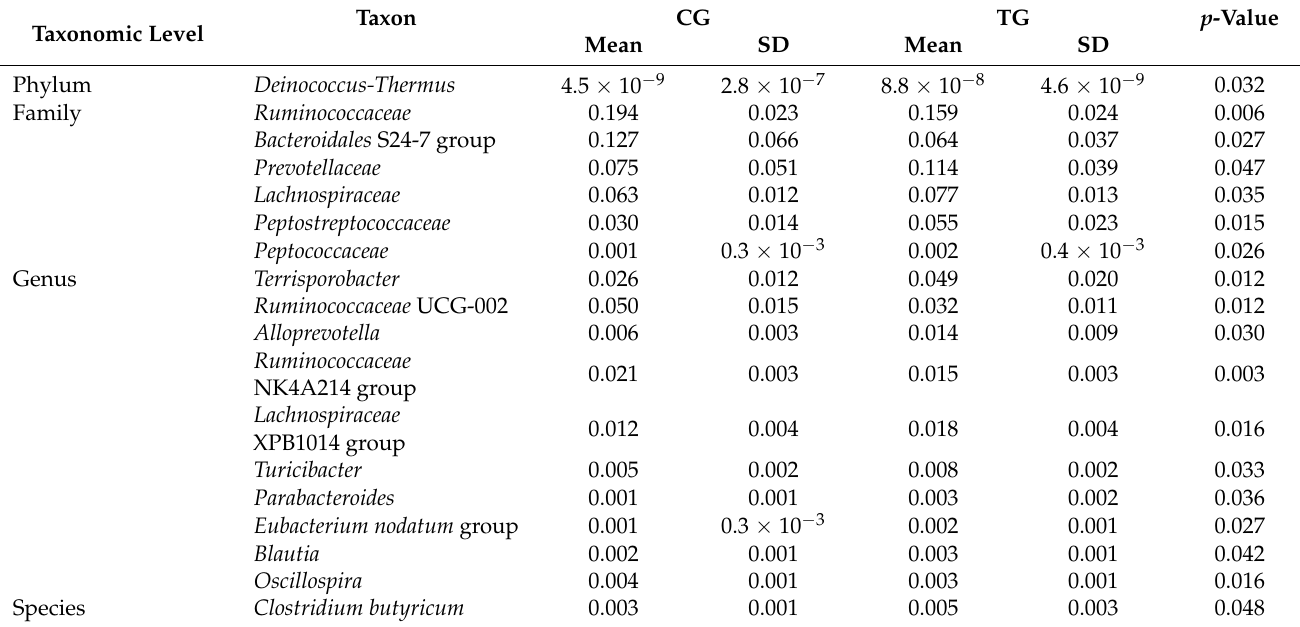
Table 2. t -test analysis of variation between groups. Differentially abundant taxa from fecal samples between the control (CG) and treatment (TG) group. Only the taxa that were significantly different between groups are listed. Taxonomic